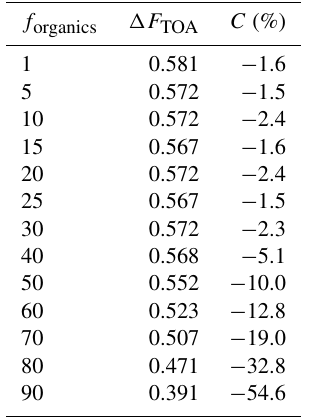
Table 3. Black carbon radiative forcing (cid:49)F TOA (Wm − 2 ) calcu- lated for various fractal dimensions ( D f ) and relative change ( C ) with respect to a reference case with D f = 1.7.